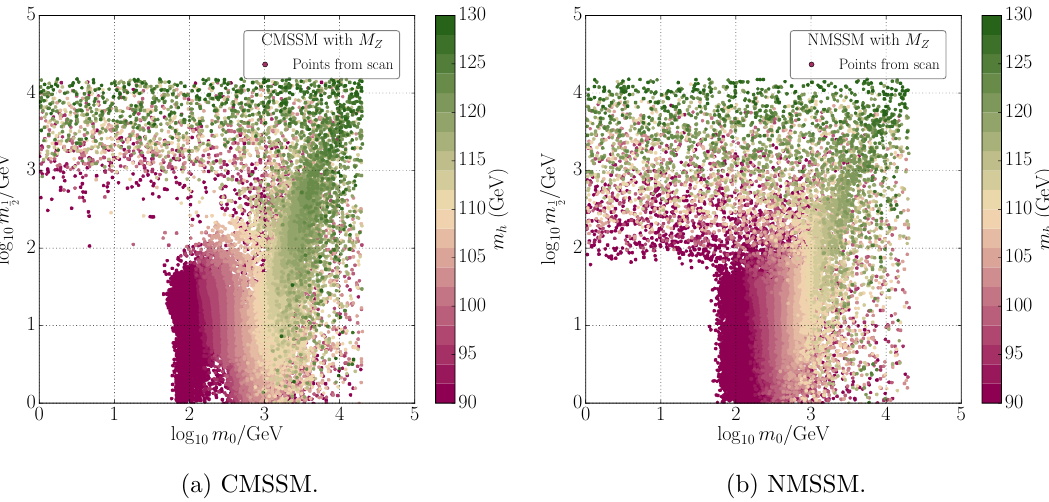
Figure 3. The lightest Higgs mass on the ( m 0 , m